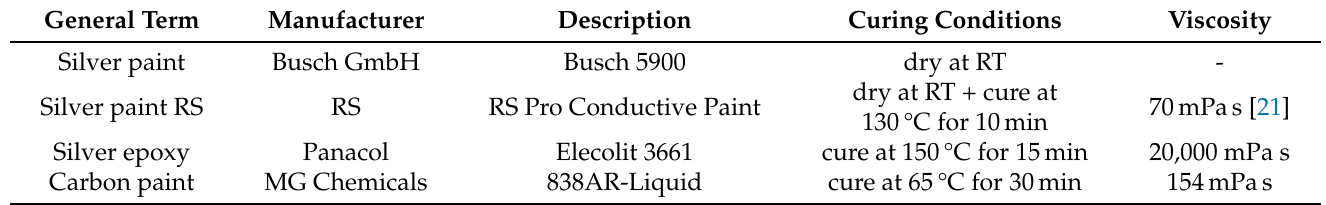
Table 1. Overview of contacting materials based on filled adhesives used in this